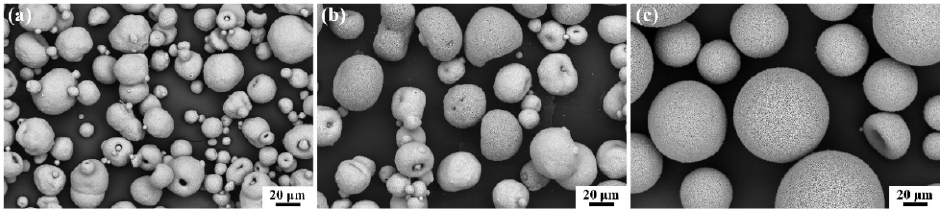
Figure 1. Morphologies of ( a ) gadolinium zirconate powders, ( b ) mixed powder of gadolinium zirconate and YSZ, and ( c ) rare-earth-doped gadolinium zirconate powders.